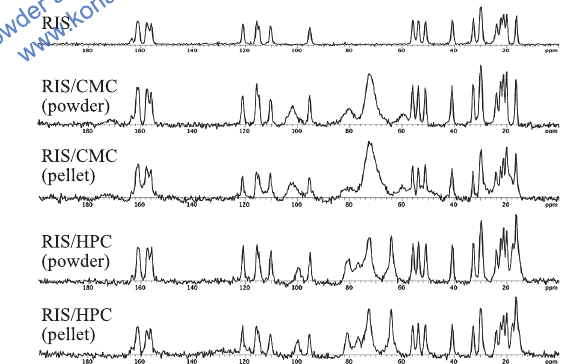
Fig. 4 R5 formation rate in different pH solutions (HPC con- centration: 1 %).